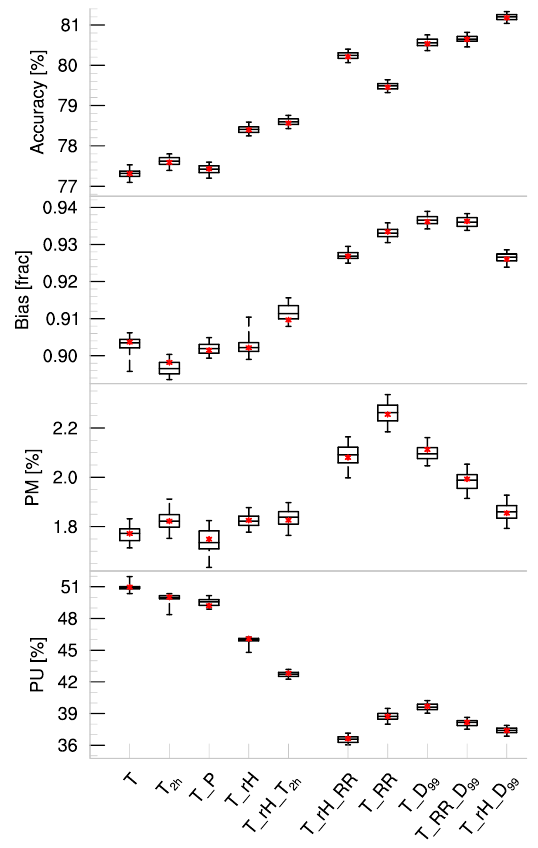
Figure 9. As Fig. 4 but for RSM including mixed phase, using two independent PP distributions (3P2D). The calculation of PM and PU differs from Fig. 4 as displayed and explained in Fig.